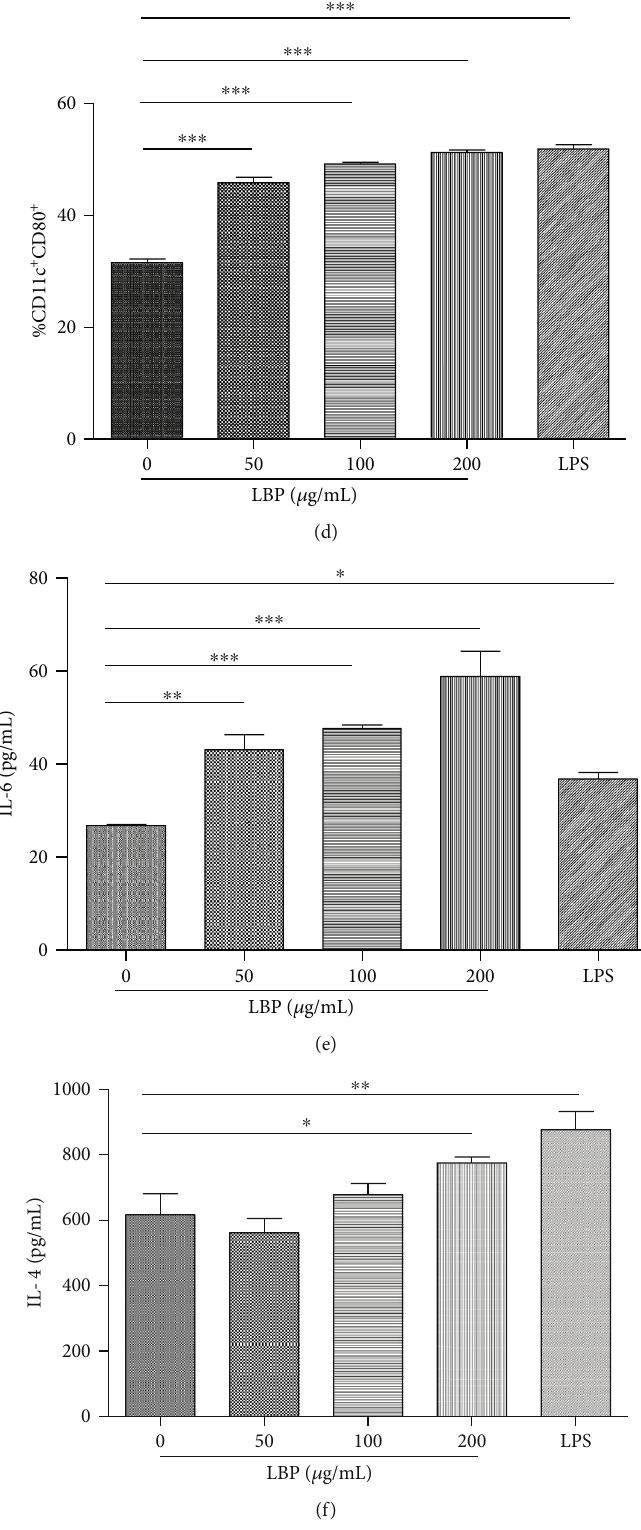
Figure 1: Phenotypic and functional change of DCs after treatment by LBP. After being cocultured with DCs for 24 h with LBP (0, 50, 100, 200, and 200 μ g/mL) and LPS (100ng/mL), FCM detected the double positive CD11c + MHCII + (b), CD11c + CD80 + (c), and CD11c + CD86 + (d) cells in fi ve groups. Supernatants were measured using ELISA kits for IL-6 (e) and IL-4 (f). Values are the mean and SD of 3 independent experiments. ∗ P < 0 : 05 , ∗∗ P < 0 : 01 , and ∗∗∗ P < 0 : 001